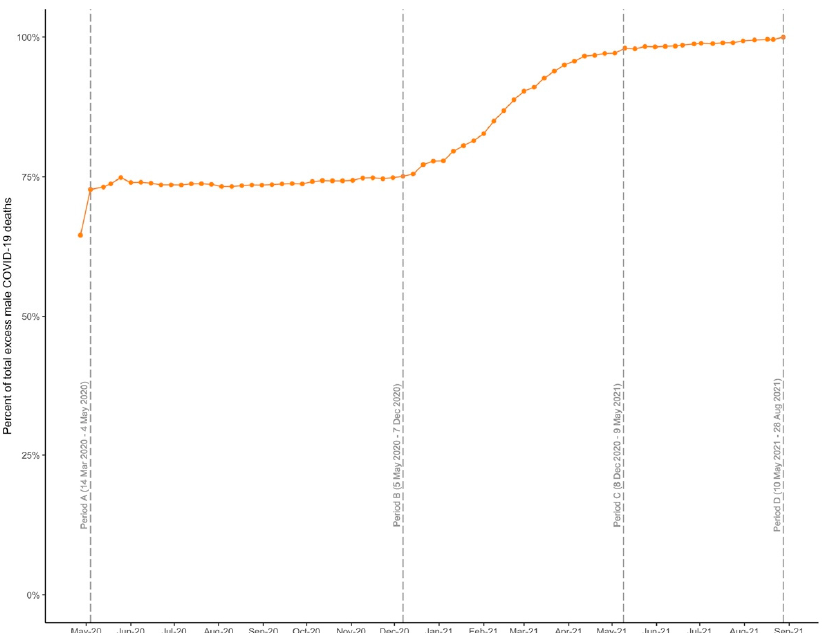
Figure 1. Cumulative excess male COVID-19 deaths by week as a proportion of total excess male COVID-19 deaths during the study period (14 March 2020–28 August 2021).